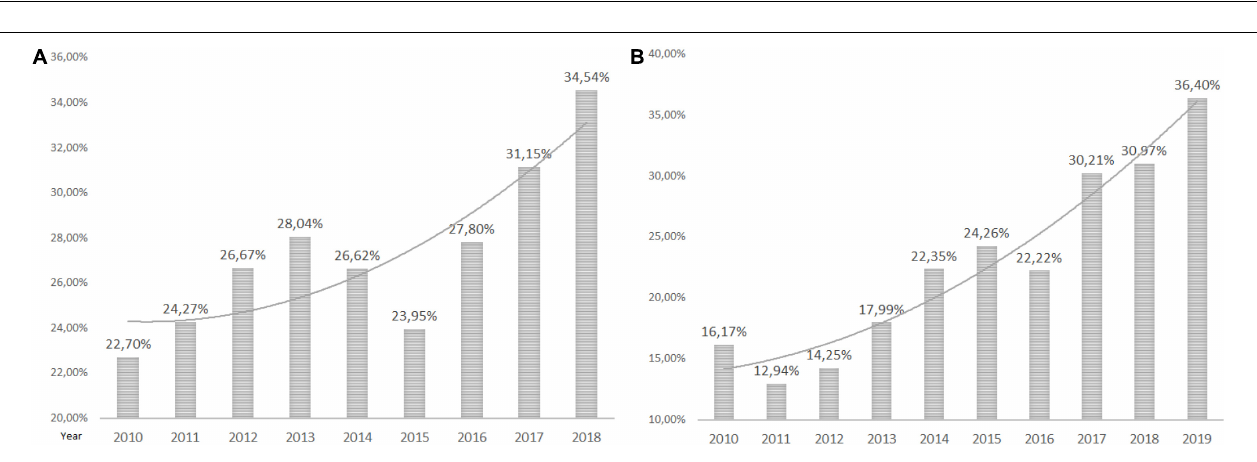
FIGURE 3 | Head and neck cancer patients with PEG. (A) The percentage of head and neck cancer patients with gastrostomies in Poland and (B) the percentage of head and neck cancer patients with gastrostomies on HEN.